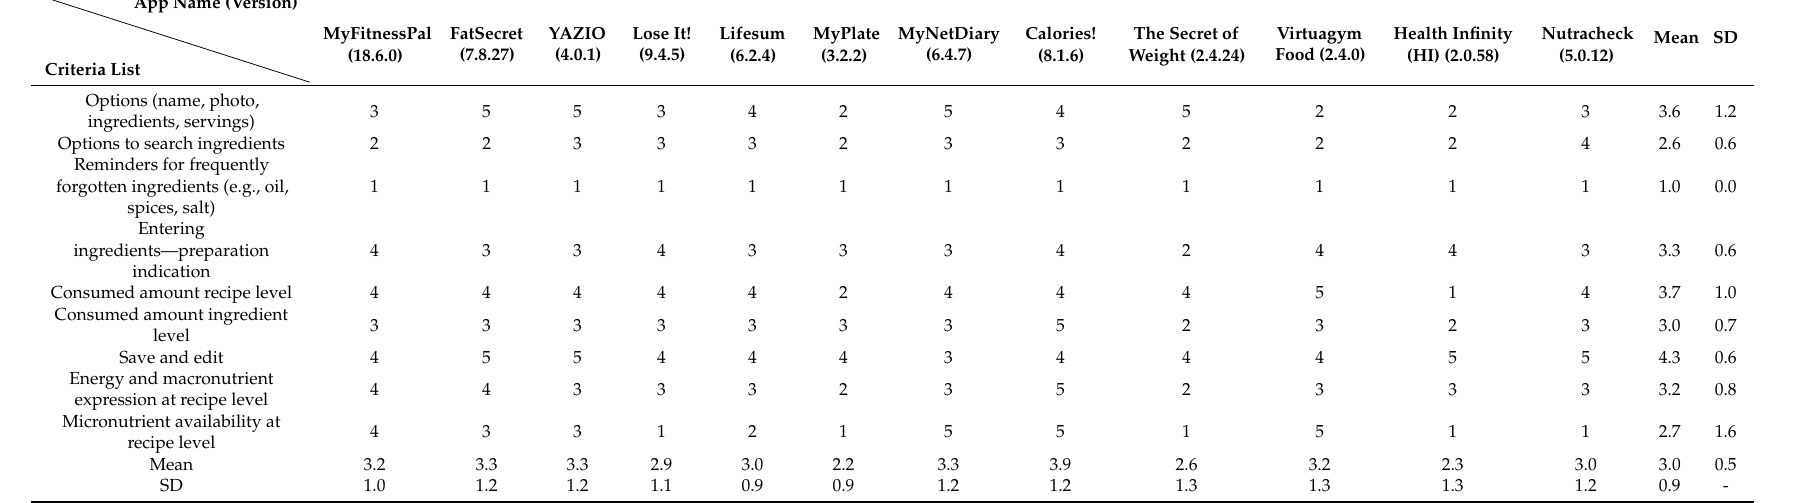
Table 3. Agreed scores for the recipe function of 12 popular dietary assessment apps using the criteria list based on a 1(low)–5 (high) scale.